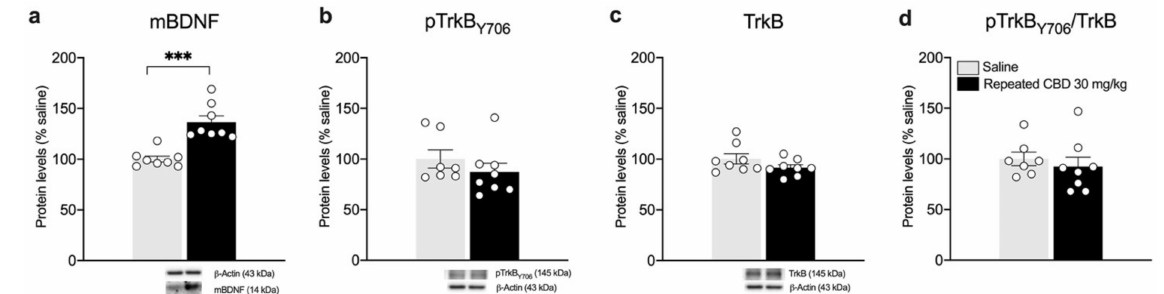
Figure 9. Effects of repeated CBD exposure on mBDNF and TrkB receptor protein levels in the striatum. Rats were treated with repeated injections of 30 mg/kg for seven days and killed twenty- four hours after the last treatment. Protein levels of mBDNF ( a ), phospho(p)-TrkBY706 ( b ), TrkB ( c ), and of the ratio pTrkB/TrkB ( d ) measured in the homogenate of the striatum are expressed as percentages of saline-treated rats. Below the graphs, representative immunoblots are shown for mBDNF (14 kDa), pTrkBY706 (145 kDa), TrkB (145 kDa), and β -Actin (43 kDa) proteins. Bar graphs represent the mean ± SEM from eight independent determinations for each experimental group. Unpaired Student’s t -test. *** p < 0.001 vs. saline-treated rats. Saline n = 8 (pTrkB n = 7), CBD 30 mg/kg n = 8.